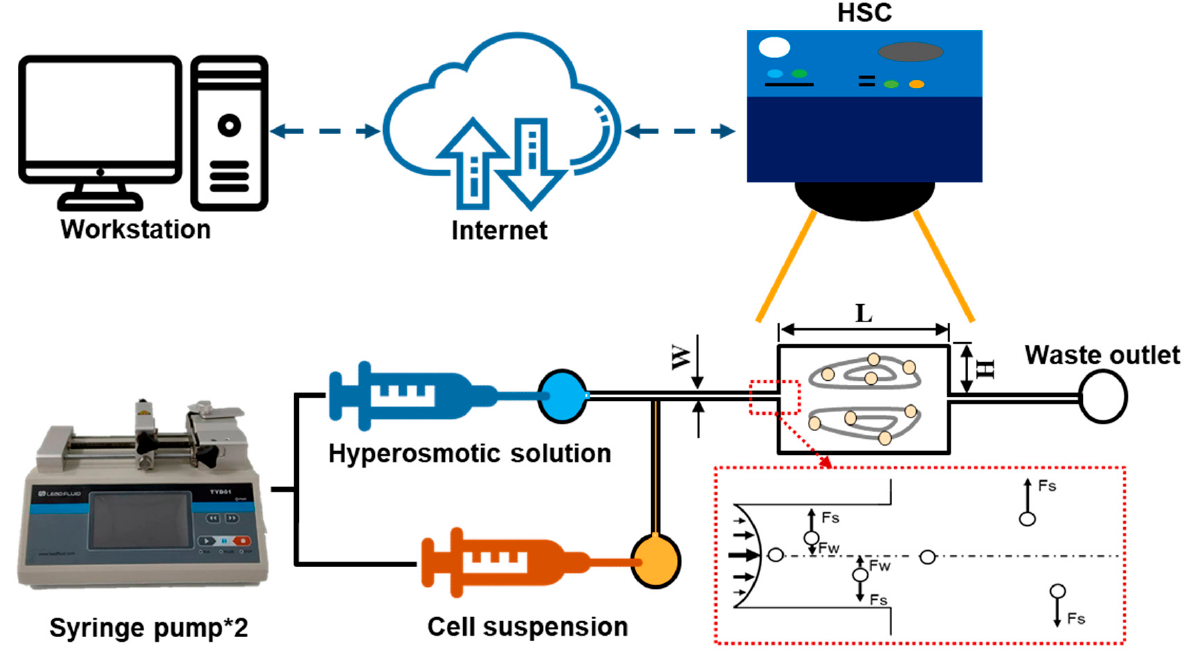
Figure 1. Schematics used for direct observation of the cells trapped in the micro-vortex system to derive the transient volume change profile. The PDMS microchannel has the featured geometries: W: 30 µ m, H: 300 µ m, L: 900 µ m and thickness: 50 µ m. For image processing, the collection of 24-bit color photos captured by the high-speed camera (exposure time: 50 µ s) in the observed region was first turned into 8-bit grayscale images, and the edge of every individual cell was then amplified and plotted by the canny edge detection, in which parameters, such as the aperture size, sigma, and high and low thresholds, were empirically fine-tuned for optimal graphing results. Furthermore, the images were filtered through the basic and advanced morphology operations; the basic operation repaired discontinuities at the edges and helped to form closed objects, while the advanced function filled the objects with pixels and removed critical particles that were either oversized or undersized, which represented cell clusters or cell debris, respectively.